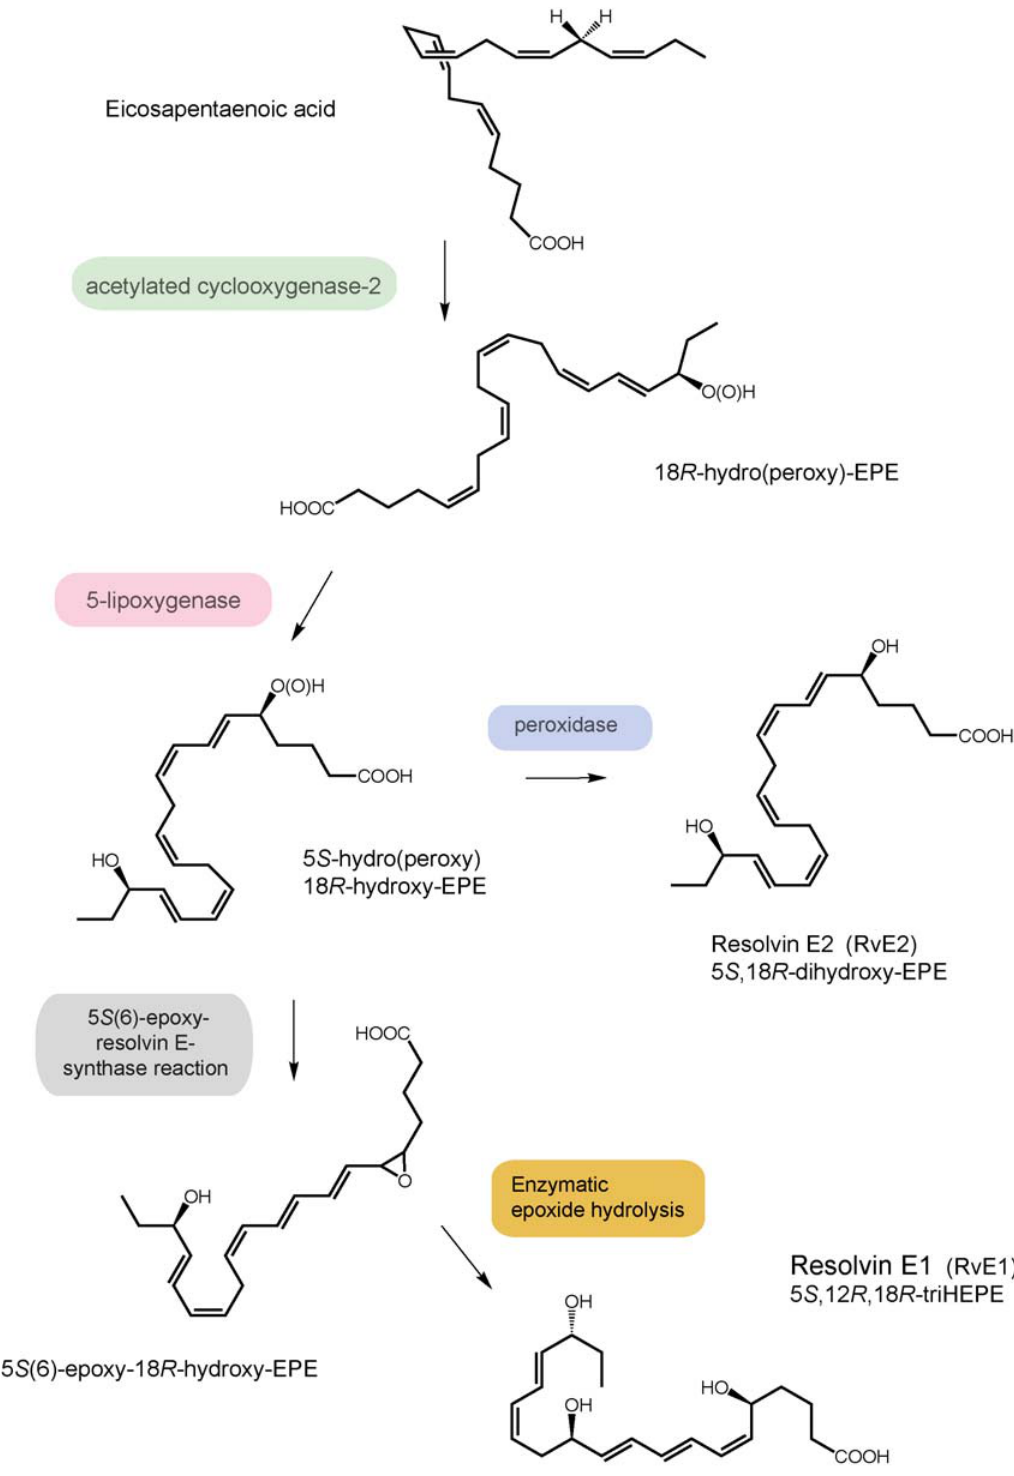
FIGURE 2. Biosynthesis of E-series resolvins. EPA is the endogenous substrate for the formation of E-series resolvins, RvE1 and RvE2. EPA is first oxygenated by COX-2, acetylated in its catalytic center by aspirin, to form 18 R -hydroperoxy-EPE, which is subsequently oxygenated by neutrophil 5-LO to form 5 S -hydroperoxy-18 R -HEPE. RvE1 is formed via the formation of an epoxide and subsequent hydrolysis. RvE2 is formed by reduction of the hydroperoxy